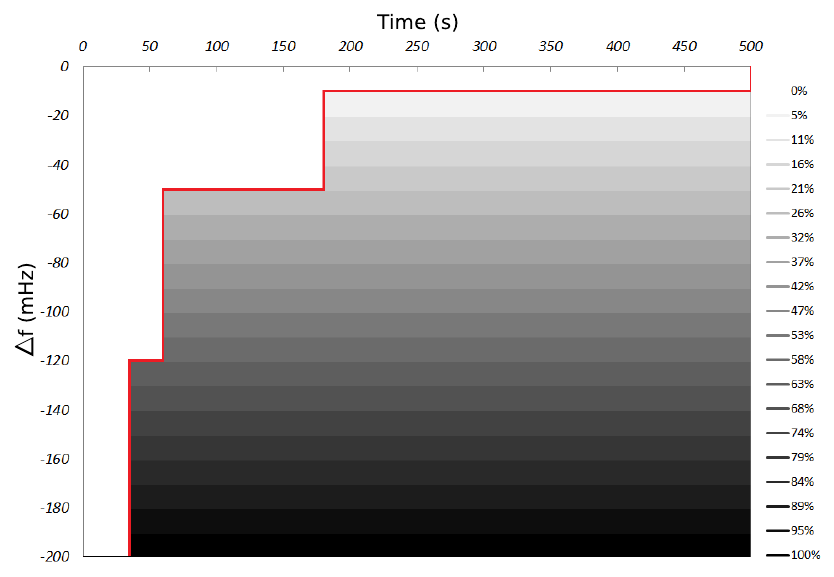
Figure 8. Percentage of load